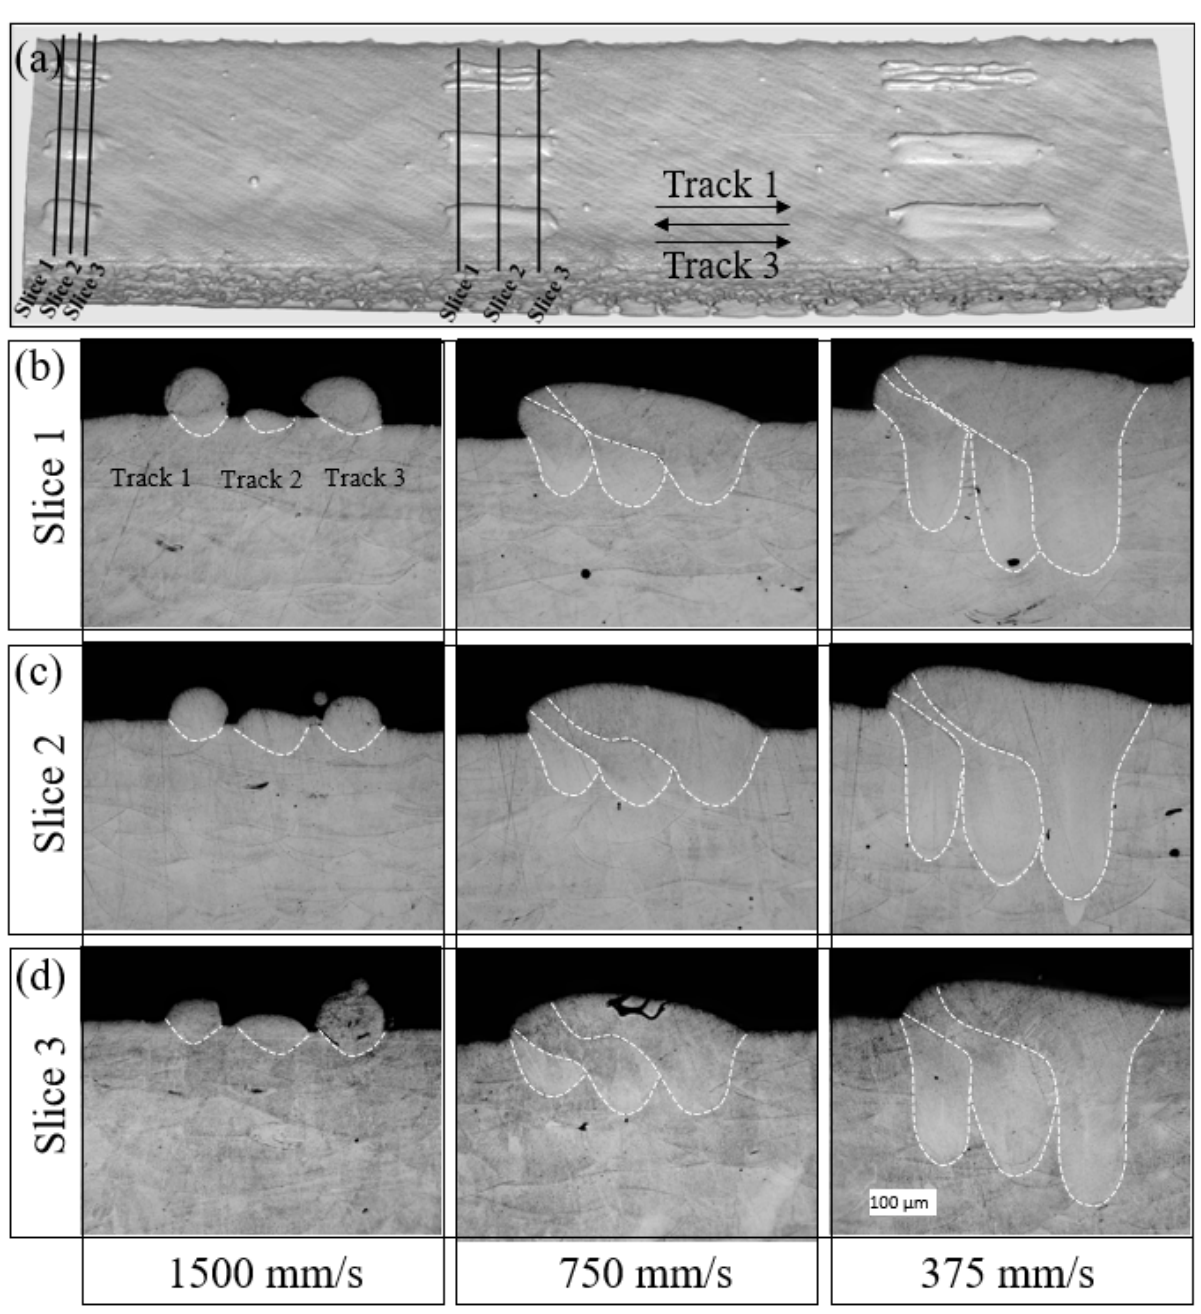
Figure 9. ( a ) Location of the three sections, and transverse melt pool boundary from ( b ) slice 1, ( c ) slice 2, and ( d ) slice 3 of 0.5 mm scan length formed with 195 W laser power, 120 µm hatch spacing and scanning speeds of 1500 mm/s (left), 750 mm/s (middle), and 375 mm/s (right). The melt pool boundaries obtained from three different regions, as shown in Figure 9a, were achieved for a 1 mm scan length and are shown in Figure 10. There was a notice- able difference between the melt pool boundary obtained with 0.5 mm and 1.0 mm scan lengths. The melt pool boundary obtained from slice 1 shows the overlap between track 2 and track 3, where the laser turns. In the laser-turn region, the melt pool of the second track may not solidify completely when the laser scans the third track. Hence, the melt pool from the third track will merge with the melt pool from the second track. However, there was no such overlap between track 1 and track 2, as the region includes the begin- ning of the first track and it solidifies when the melt pool from the second track reaches the beginning of the first track. The melt pool profile obtained in the middle of the track (slice 2) showed a more consistent overlap between the tracks. This is different from the overlaps observed in slice 1, and the merging of the melt pool from two tracks was not